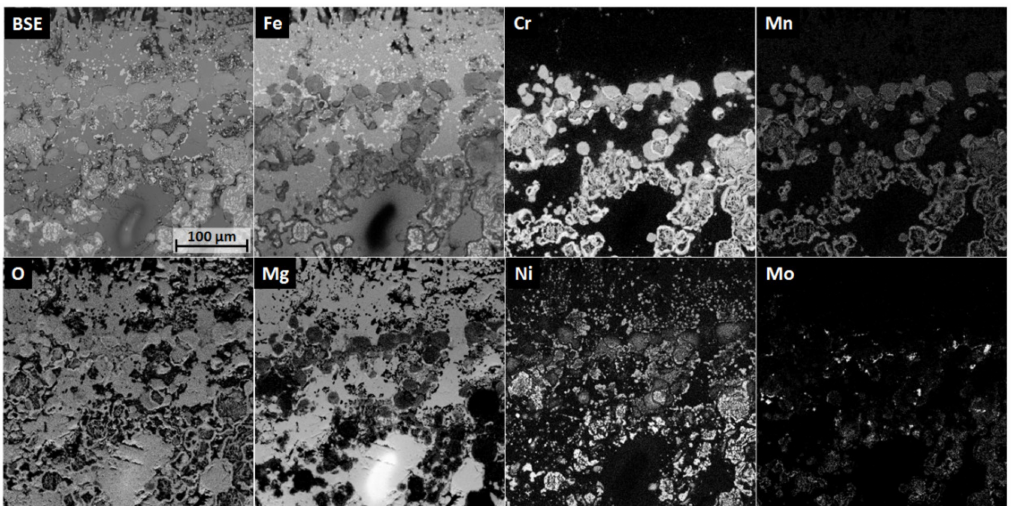
Figure 16. Detailed EDS elemental mapping at the aluminum alloy–steel–MgO composite interface of the C_1000 sample.